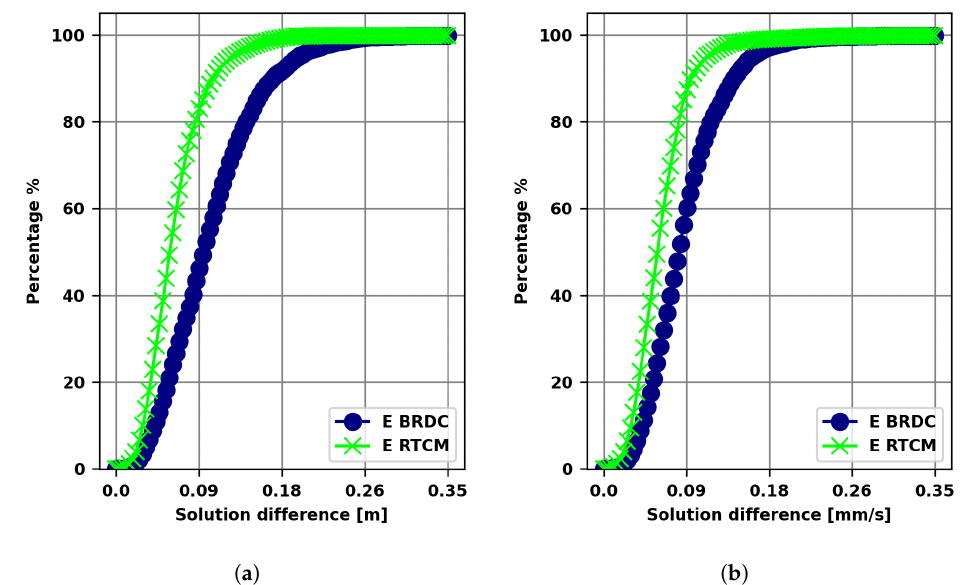
Figure 6. ( a ) Cumulative 3D position differences between UNIPD and CNES-POD solutions. ( b ) Cu- mulative 3D velocity differences between UNIPD and CNES-POD